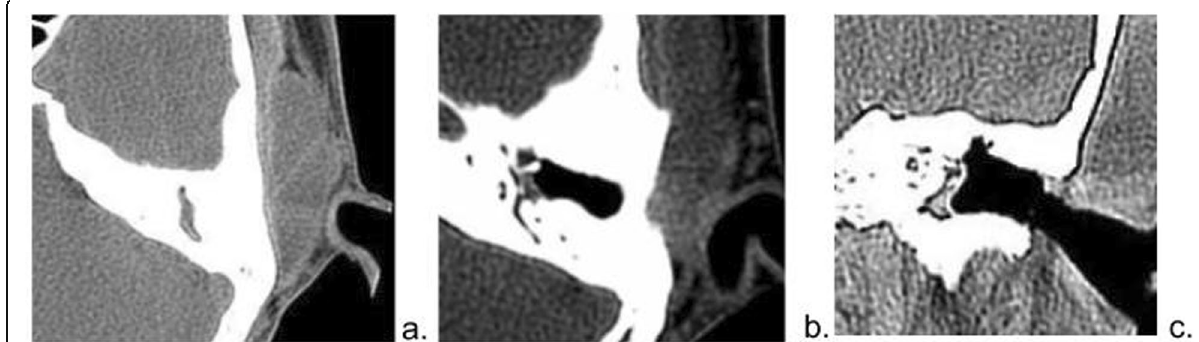
Fig 1 Computed tomography of the left temporal bone showing a non-enhancing cystic lesion in the left temporal fossa. a , b Axial view and scutum and ossicular erosion. c Coronal view